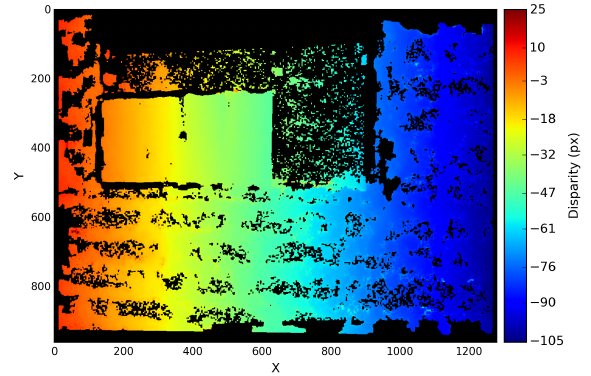
Figure 9 Disparity map using 30000 random LIDAR points as seeds for GOTCHA stereo